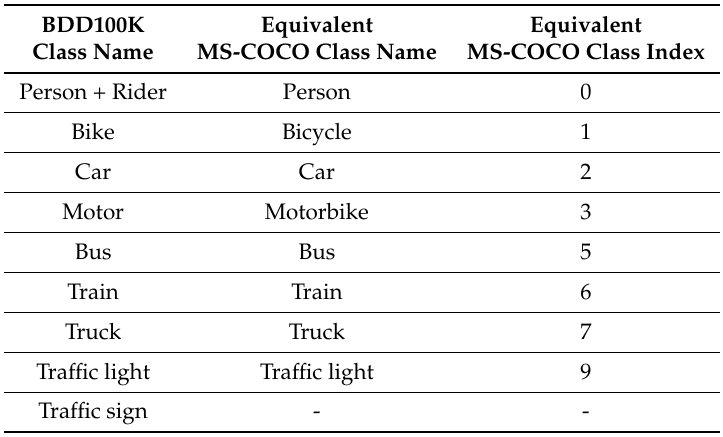
Table 1. Assignment among the MS-COCO and the BDD100K